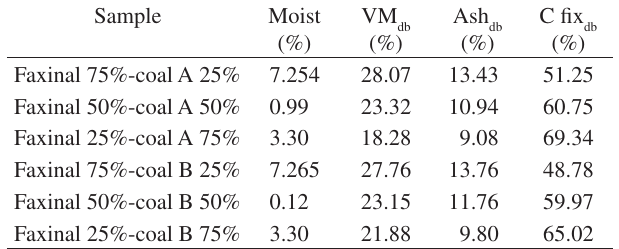
Table �. Coal mixtures proximate analysis (moisture, volatile matter, ash and fixed carbon), in dry basis. Sample